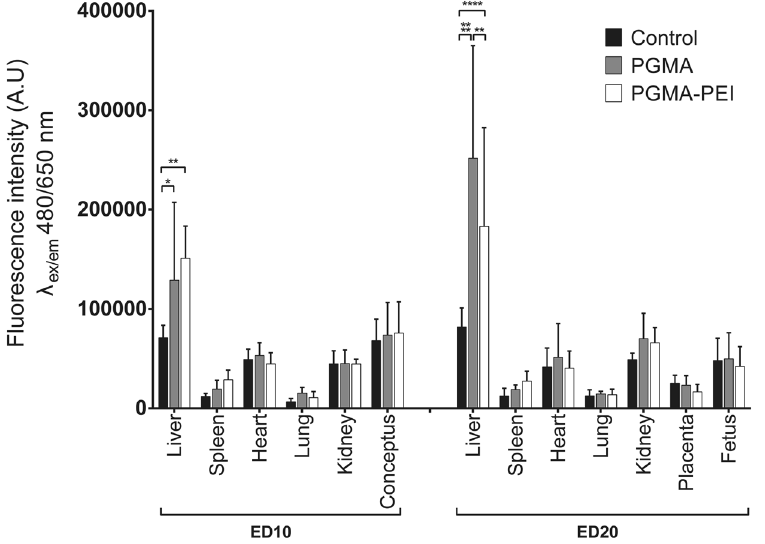
Figure 2. Fluorescence intensity measurements of ED10 and ED20 tissue homogenates. Data reported as mean ± SD (n = 4 per group). One-way ANOVA was used for statistical analysis; * p ≤ 0.05; ** p ≤ 0.01; **** p ≤